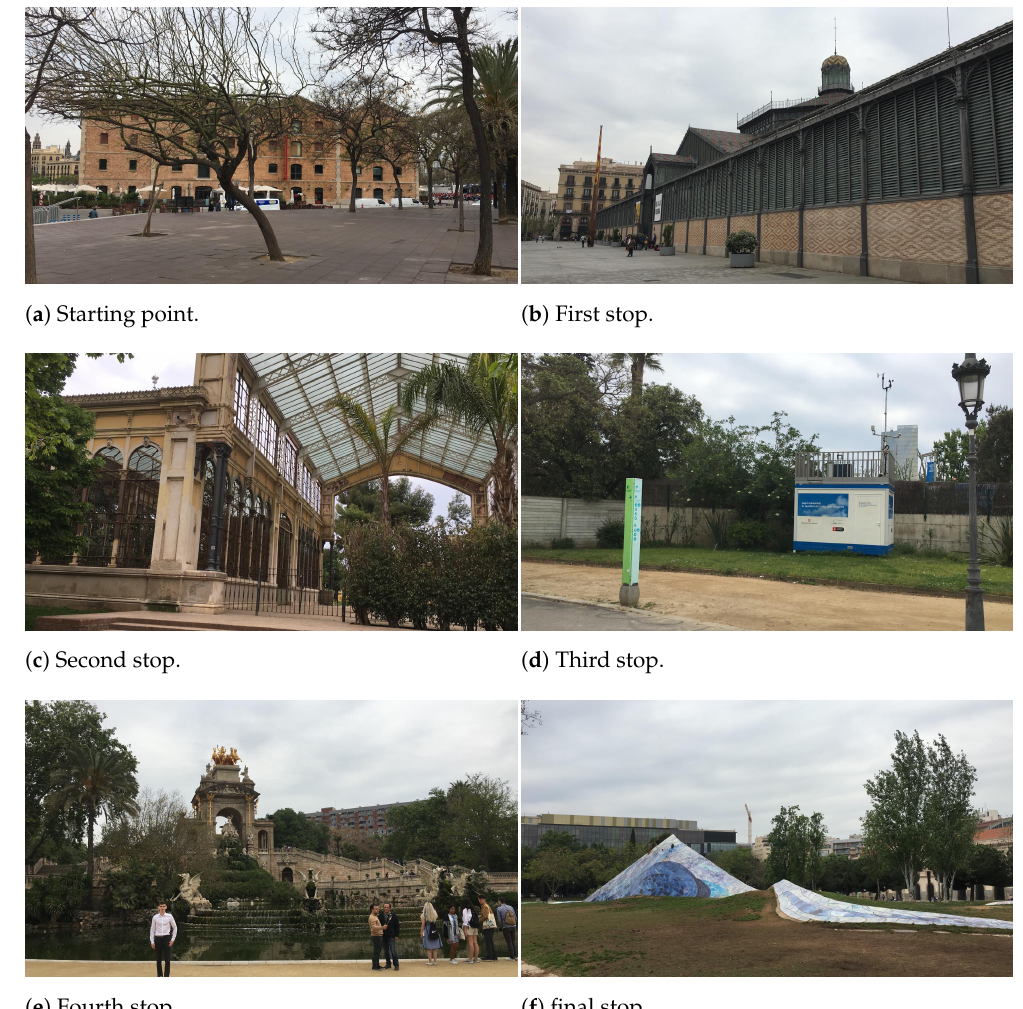
Figure 3. Images of the stopping points on the Conscious